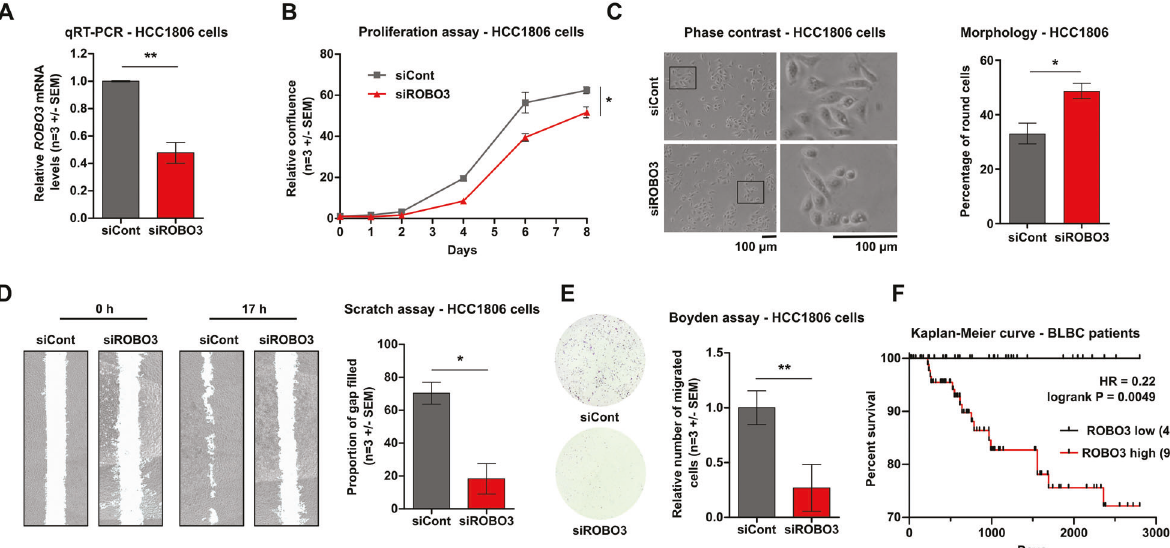
Fig. 3 Human ROBO3s is essential for cell proliferation and cell migration. A Validation of siROBO3 knockdown in HCC1806 cells relative to siRNA control by qRT-PCR. B Proliferation assay of HCC1806 treated with siROBO3. Relative con fl uency was measured by Celigo ® and normalized to day 0. Statistics were performed on the area under the curve (AUC). C Phase-contrast images of HCC1806 cells treated with siROBO3 or siRNA control (left panel). Quanti fi cation of the percentage of round cells (right panel). D Scratch assay gaps 0 h and 17 h after seeding. HCC1806 cells were treated with siROBO3 and siRNA control (siCont) respectively (left panel). Quanti fi cation of migratory cells based on relative fi lled gap area (right panel). E Boyden chamber based migration assay of HCC1806 cells treated with siROBO3 or siCont, respectively, and stained with crystal violet (left panel). A quanti fi cation of the migrated cell number is provided in the right panel. F Kaplan- Meier curve depicting the survival of BLBC patients (source TCGA-BRCA dataset) grouped according to ROBO3 expression levels ( ROBO3 low n = 45 patients, ROBO3 high n = 95 patients). Log-rank (Mantel-Cox) Test ( p = 0.0049). Error bars represent mean ± SEM. All experiments were performed in three biological replicates. Unpaired t-test. * p < 0.05; ** p < 0.01; *** p <